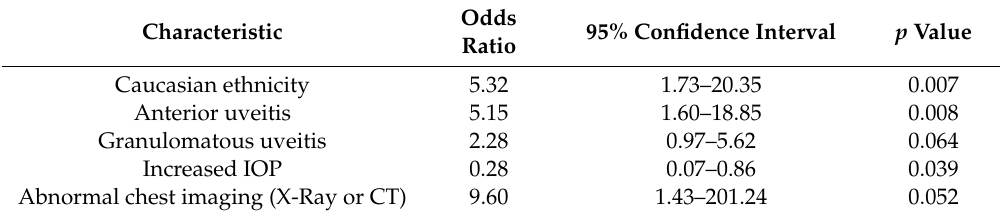
Table 5. Factors associated with ocular and extraocular recovery after stepwise